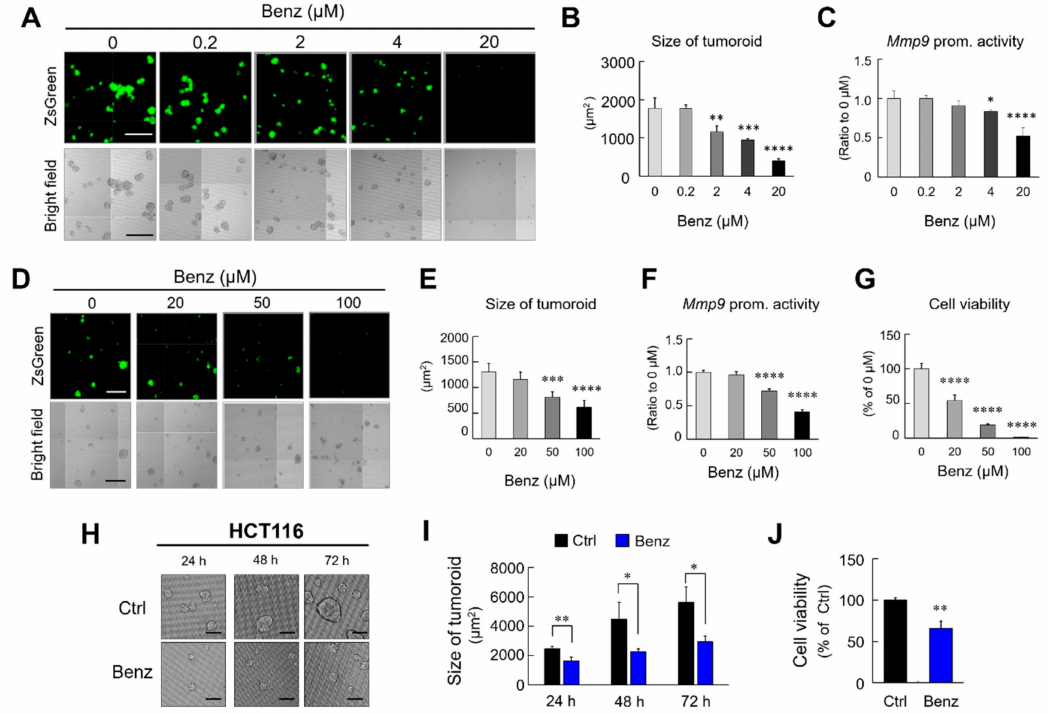
Figure 2. Inhibitory e ff ects of Benztropine on tumoroids formed by mouse- and human-derived colon cancer cells. (A to C) LuM1 / m9 cells were treated with Benz (0, 0.2, 2, 4, and 20 µ M) for 72 h. ( A ) Representative images of tumoroids with LuM1 / m9 reporter fluorescence (top) and bright fields (bottom). Scale bars, 500 µ m. ( B ) Size of tumoroids altered by treatment with Benz. ( C ) MMP9 promoter activities altered by Benz. ( D – G ) Preformed tumoroids of LuM1 / m9 cells were treated with Benz (0, 20, 50, and 100 µ M) for 24 h. ( D ) Representative images of tumoroids with LuM1 / m9 reporter fluorescence. Scale bars, 500 µ m. The size of an area greater than 300 µ m 2 was counted as a tumoroid. The ( E ) size, ( F ) MMP9 promoter activities, and ( G ) cell viability of tumoroids were decreased after treatment with Benz. The values were shown as the average value of 4 wells. Mean ± SD. * P < 0.05, ** P < 0.01, *** P < 0.001, **** P < 0.0001 (vs. untreated group). From the data, IC 50 of Benz was 16.5 µ M. ( H–J ) The e ff ects of Benz on tumoroid formation in human colon cancer cells. A human colon cancer cell line HCT116 cultured in the 3D culture system was treated with 20 µ M Benz for 72 h. ( H ) Representative images of tumoroids treated with Benz for 24 h, 48 h, and 72 h. Scale bars, 100 µ m. ( I ) The size of tumoroids altered by treatment with Benz. The size of 33 tumoroids in each well was measured. Mean ± SD, n = 3 wells. ( J ) Tumoroid cell viability evaluated by cellular ATP content. The values were shown as % of the control. Mean ± SD, n = 3 wells. * P < 0.05, ** P < 0.01 (vs. untreated